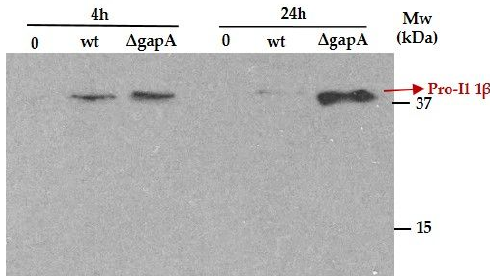
Figure 8. Western blot analysis for visualization of pro-IL-1 β form in cell lysates from BMDMs that were noninfected (0), infected with wt strain (wt), and infected with ∆ gapA at 4 and 24 h